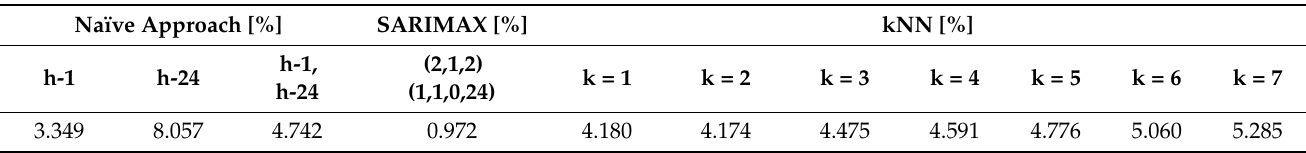
Table 15. MAPE values for naïve approach, SARIMAX model, and kNN algorithm for the three-dimensional verification case. Naïve Approach [%] SARIMAX [%] kNN [%]